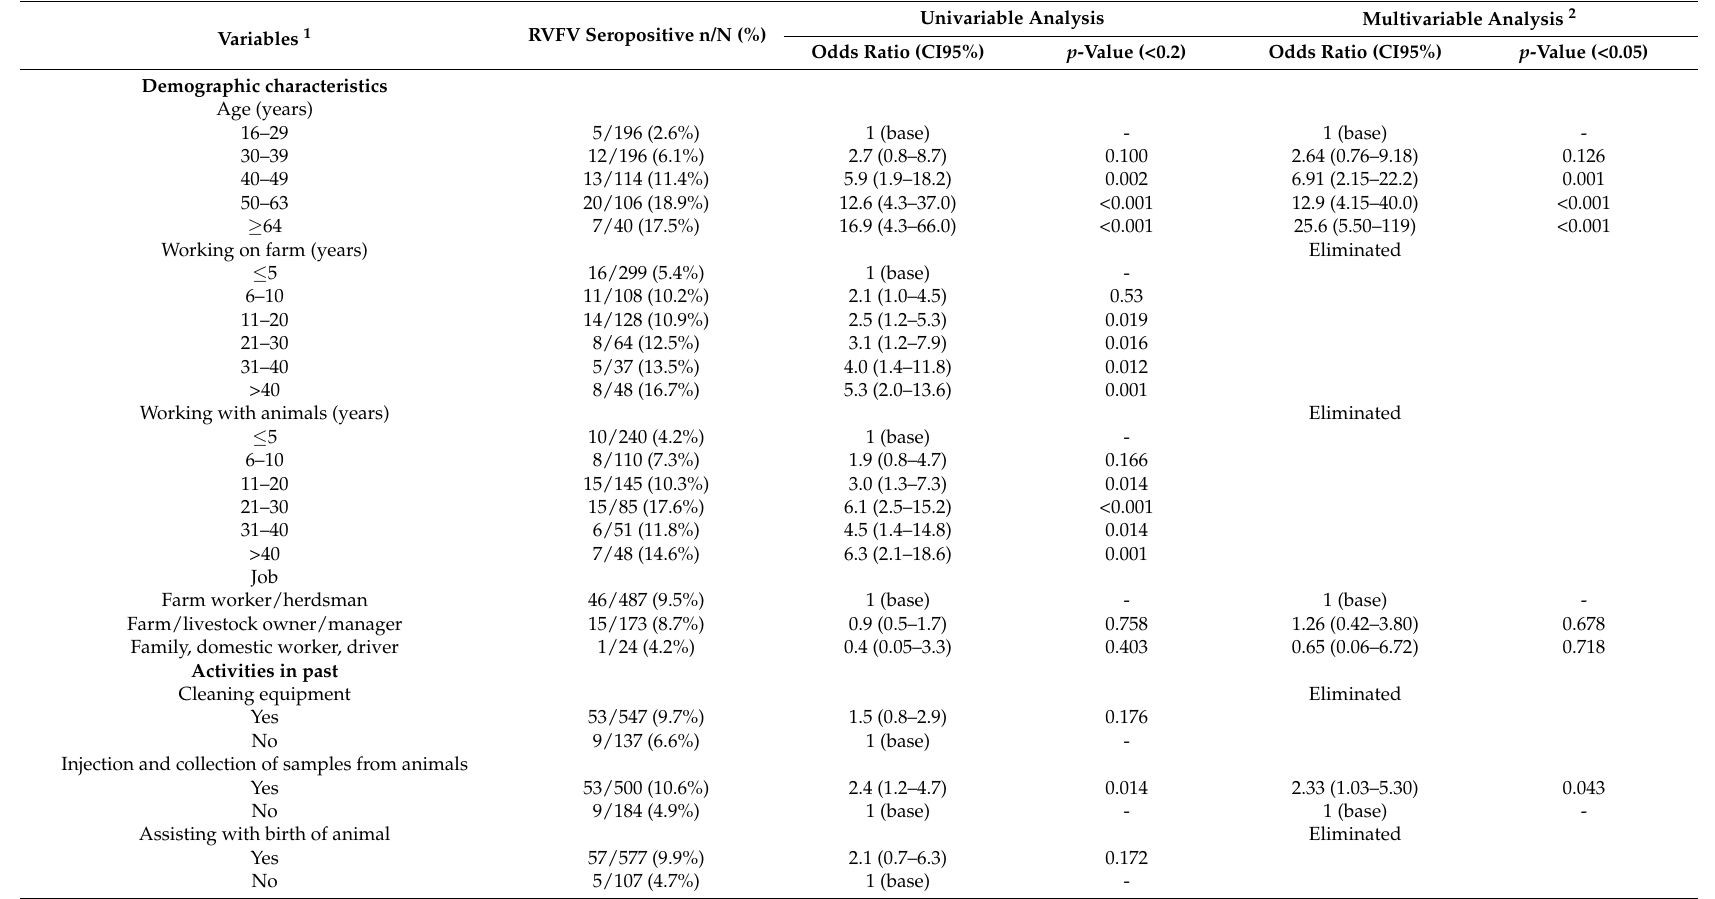
Table 1. Univariable and multivariable logistic regression analysis of potential risk factors for Rift Valley fever virus (RVFV) seropositivity in people working on farms in the study area of South Africa during